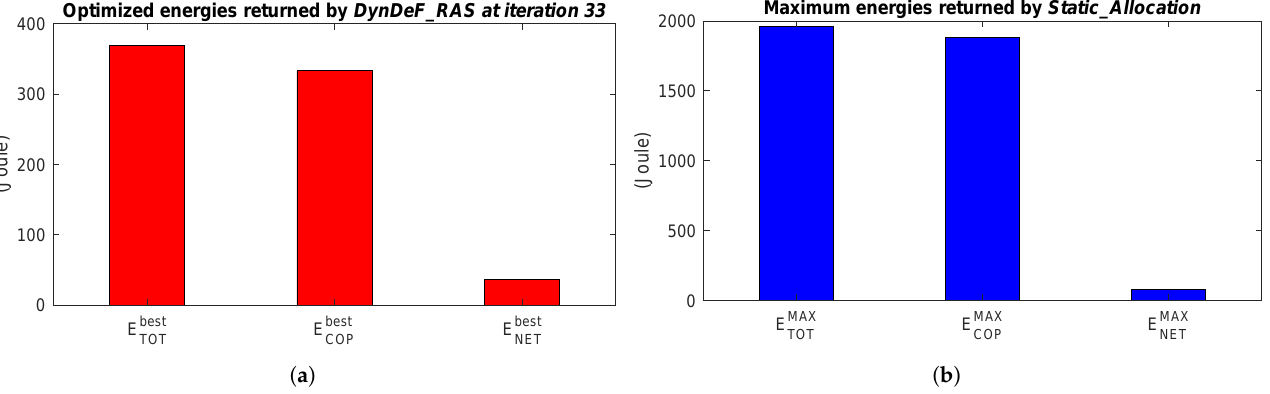
Figure 14. Values under topology T 1 of the: ( a ) optimized energy consumption returned by the DynDeF_RAS function and ( b ) energy consumption returned by the Static_Allocation